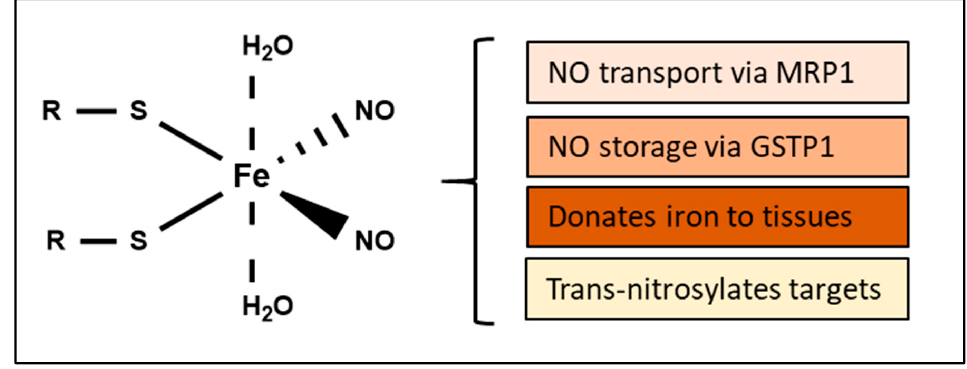
Figure 6. The structure and biological functions of DNICs. R may be either glutathione or cysteine. Studies using EPR indicate an equilibrium between free DNIC complexes and protein- bound DNICs [15,141–143]. Importantly, DNICs, like RSNOs, are endogenous NO carriers and are formed via the reaction of iron and NO with low molecular weight thiols, pep- tides [144–146], and some proteins [47,116,147]. The binding of DNICs to proteins is facilitated by substituting a thiol ligand from the “free” DNIC with Ser, Tyr, or Cys [140]. However, dinitrosyl-diglutathionyl iron complexes (DNDGIC) are generally considered as the most abundant DNIC within cells [148], and this can be attributed to the high concentration of GSH in cells (2–10 mM)